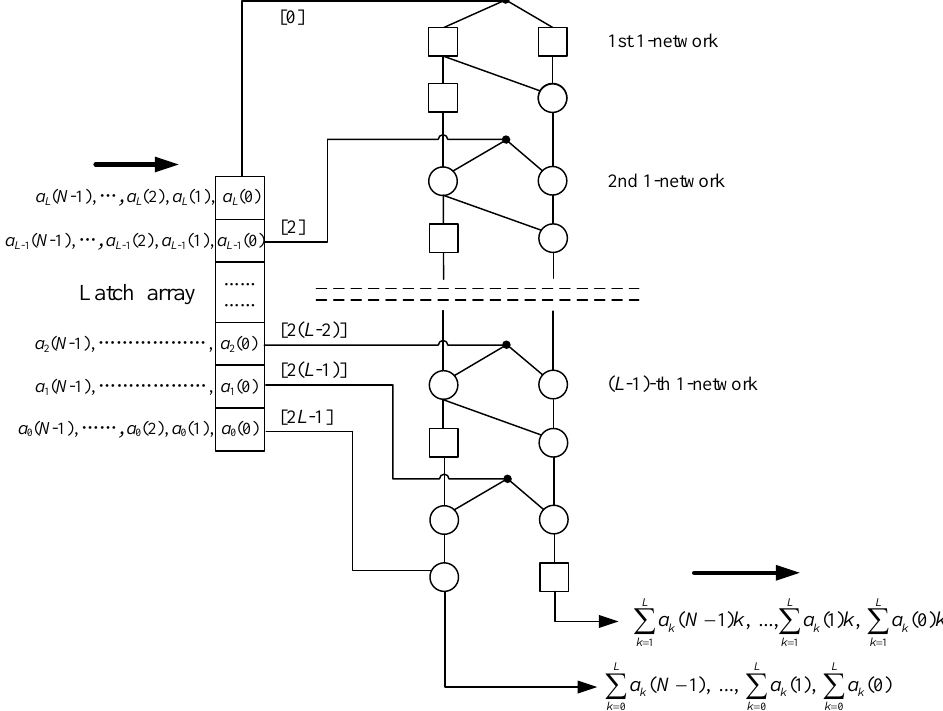
Figure 3. The systolic array for first-order moment.